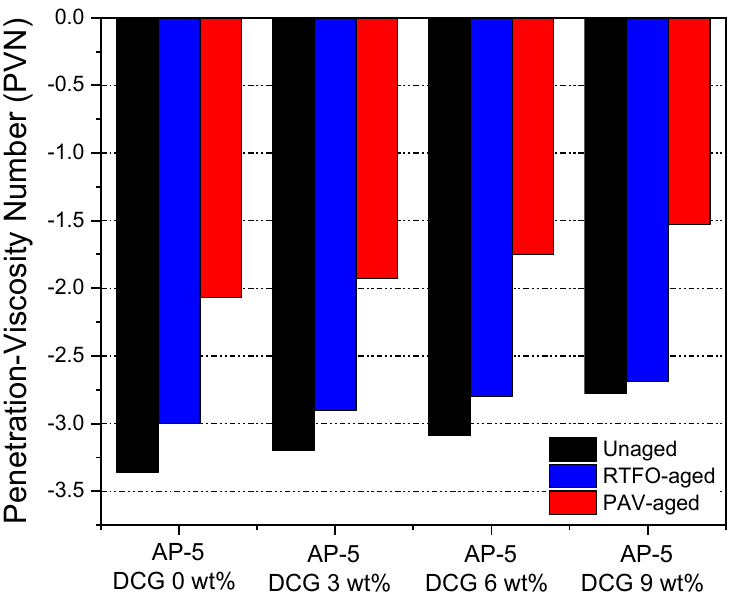
Figure 11. Influence of various fractions of DCG (e.g., 3, 6, 9 wt%) on the penetration viscosity number (PVN) of base AP-5 asphalt before and after RTFO and PAV aging.